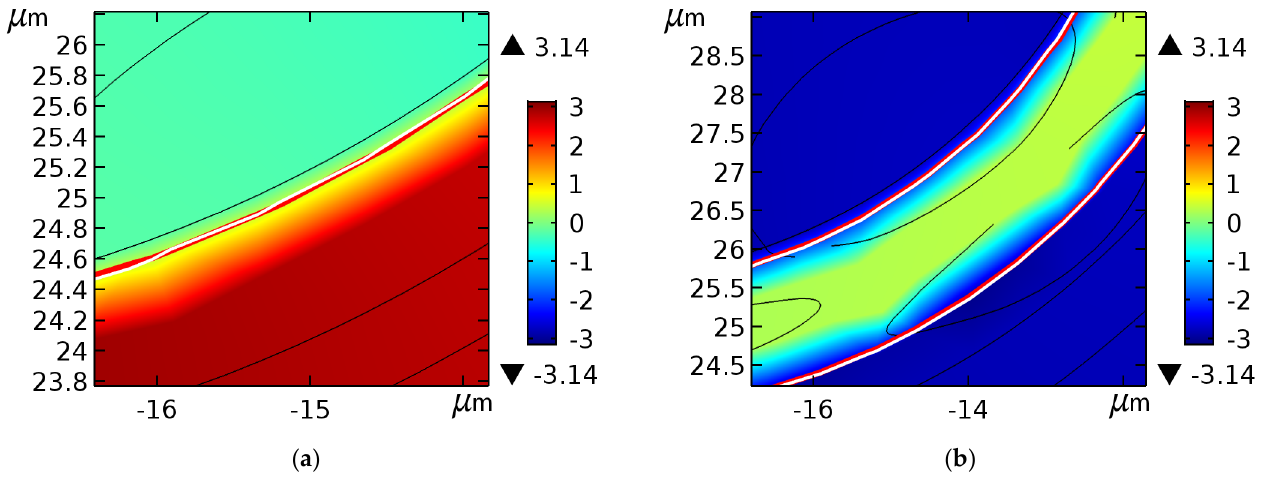
Figure 8. Phase distribution of the axial component of the electric field of the fundamental air core mode in the cladding capillary wall at a wall thickness: ( a ) d = 1 µm (the longest wavelength transmission band); ( b ) d = 2.42 µm. The phase changes from −π (dark blue) to π (dark red), with light green corresponding to zero. Thin red and white lines correspond to the condition that the real (red) and imaginary (white) parts of the axial component of electric field being equal to zero. For ( a ) red and white lines superimpose on the inner border of the cladding capillary. Other parameters are the same as in Figure 7.